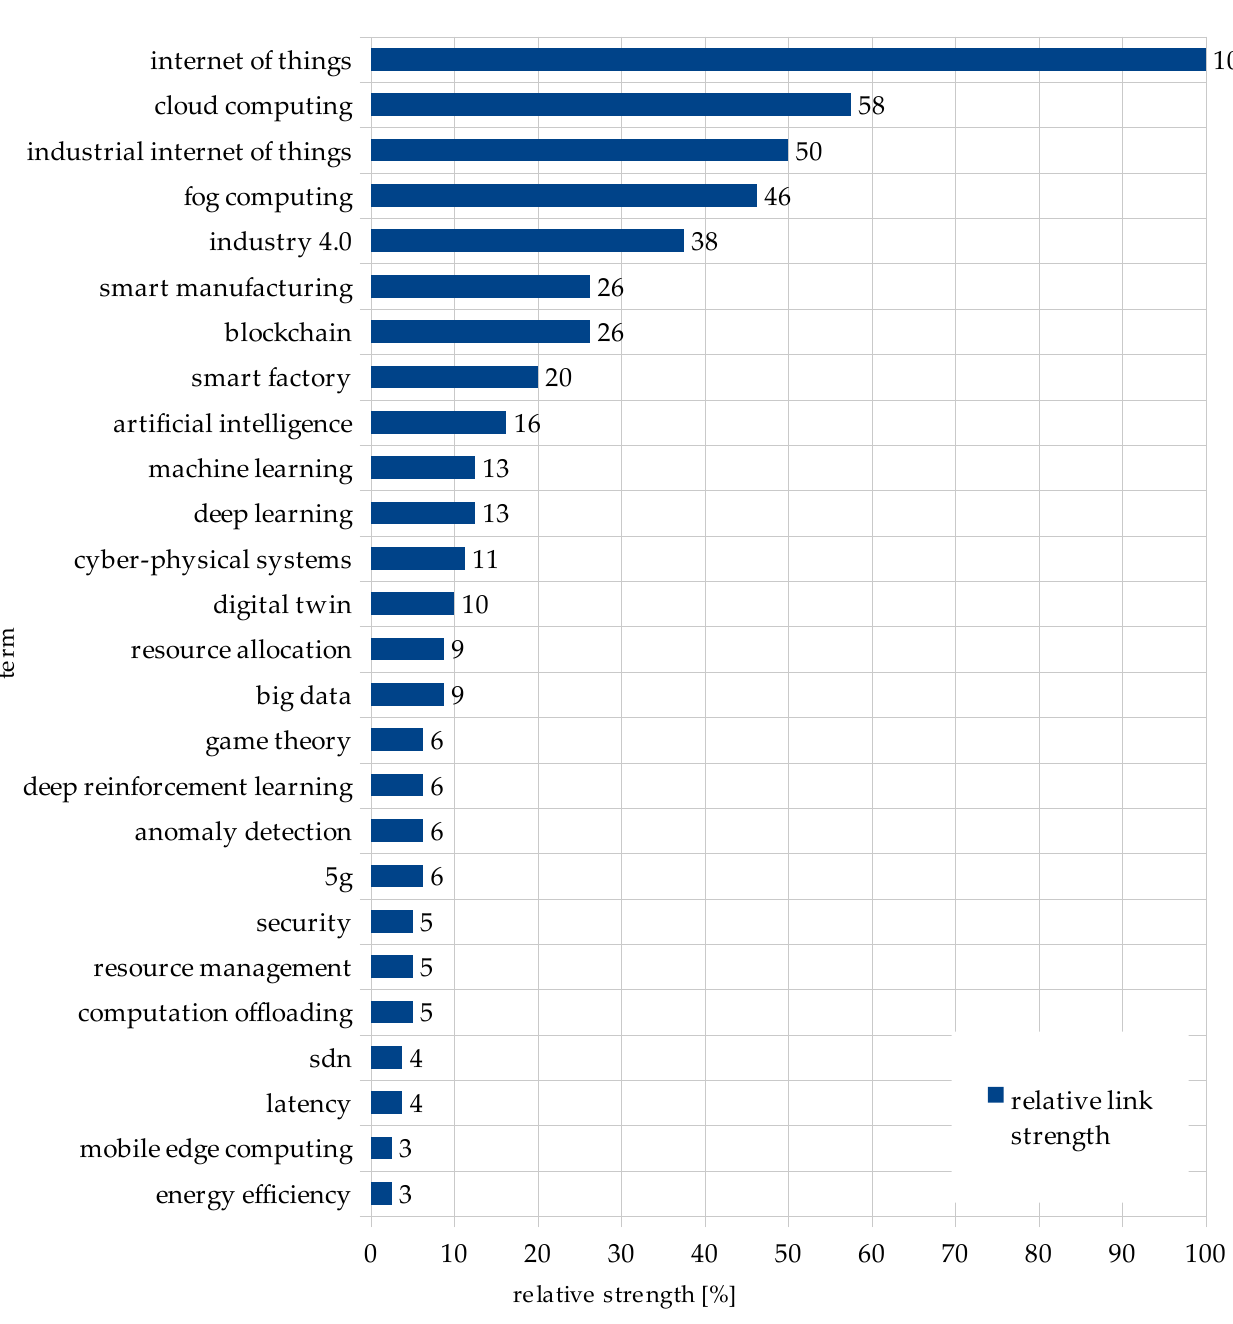
Figure 3. Relative link strength between the term Edge Computing and selected terms.